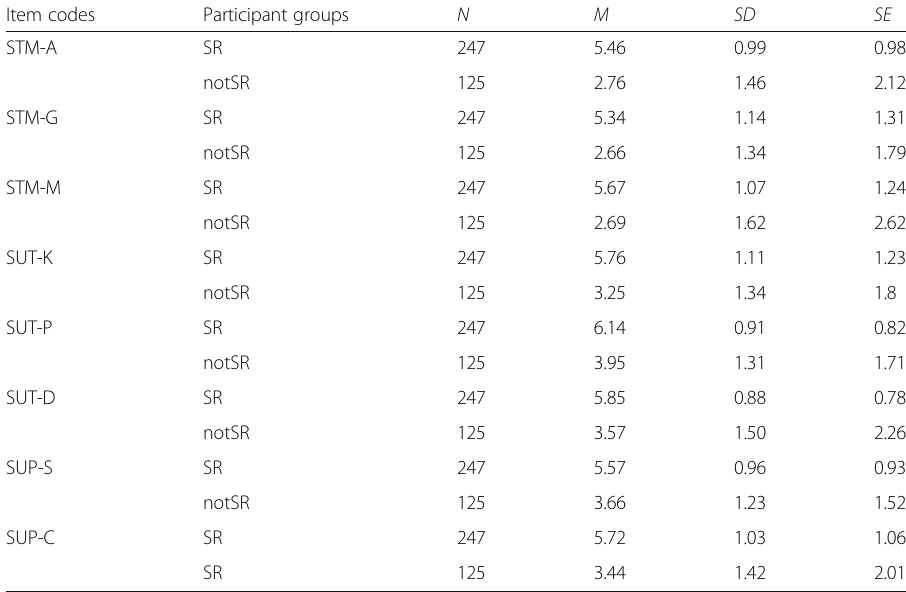
Table 10 Comparison of two groups of participants who were confident as self-regulated learners (SR) and who were confident as non self-regulated learners (nonSR) for individual items in the third part of the